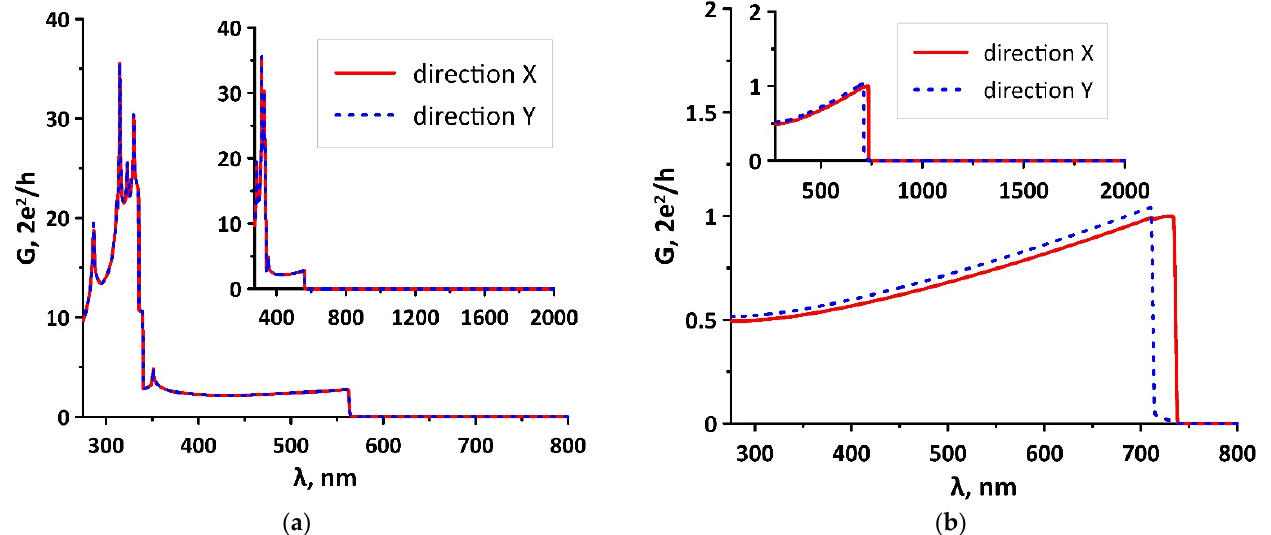
Figure 5. The dynamic conductivity spectra of monolayers of BlueP ( a ) and ZnO ( b ) monolayers for two cases of electromagnetic wave polarization (along the X and Y axes).